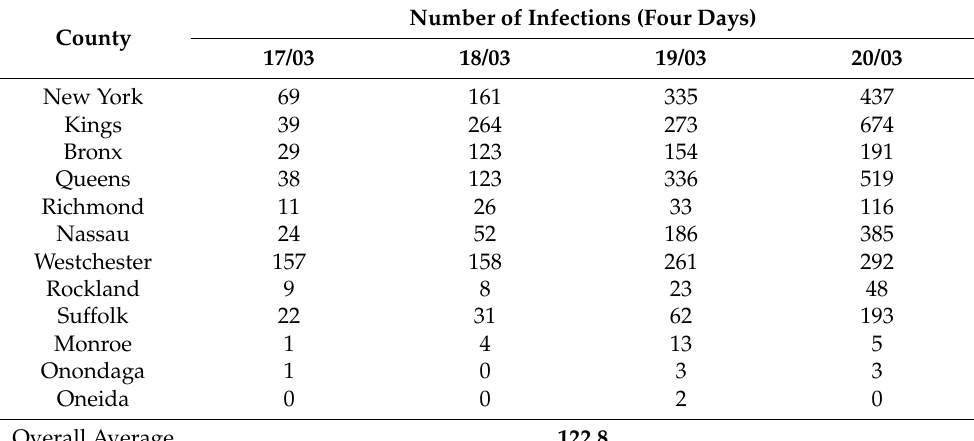
Table 3. The number of COVID-19 infections over four different days per each